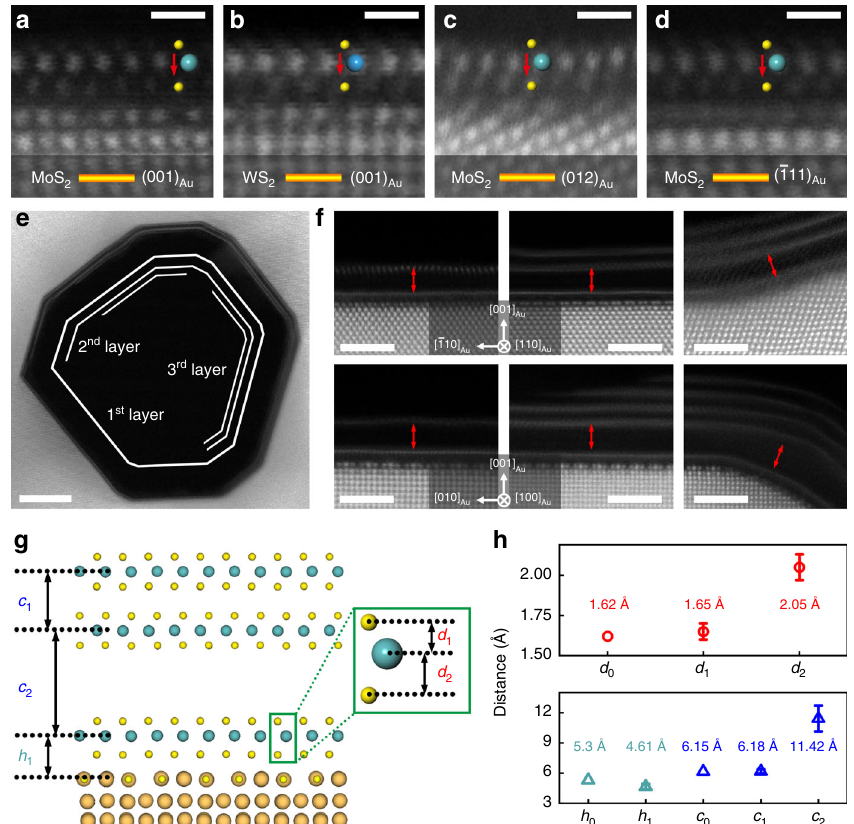
Fig. 9 Structure of monolayer and multi-layer MoS 2 on reconstructed Au (001) surfaces. a – d HAADF-STEM imaging showing the cross-sectional structures of MoS 2 and WS 2 monolayers on the reconstructed Au (001) surfaces. Scale bar, 0.5 nm. e Multi-layer MoS 2 on the internal surface of NPG. Scale bar, 5 nm. f Atomic-resolution HAADF-STEM images of multi-layer MoS 2 grown on Au surfaces viewed from the [100] Au and [110] Au directions. Scale bar, 2 nm. g Structure model of the MoS 2 on the reconstructed Au (001) surface. The d is de fi ned as the distance between Mo atom layer and S atom layer, c is the interlayer spacing between two MoS 2 layers and h is the distance between topmost Au atom layer and the nearest S atom layer in the top MoS 2 . h The comparison of d , h , and c with the values of d 0 , h 0 (ref. 13 ), and c 0 in pristine MoS 2 . The error bars represent the standard deviation of each distance. Source data are provided as a Source Data fi le. The orange, green, blue and yellow spheres represent Au, Mo, W, and S atoms, respectively.